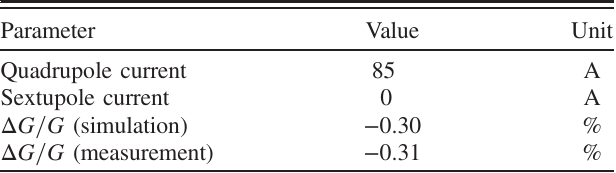
TABLE VI. Measured and simulated value of the